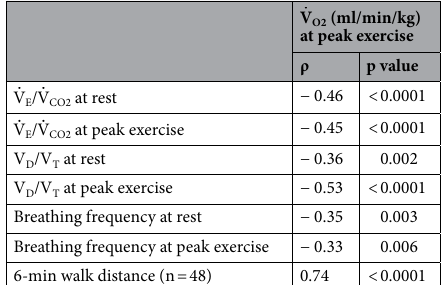
Table 2. Results of cardiopulmonary exercise testing at rest and at peak exercise (n = 69). V T tidal volume, V E minute ventilation, tidal volume ratio. Data are presented as mean ± standard deviation.